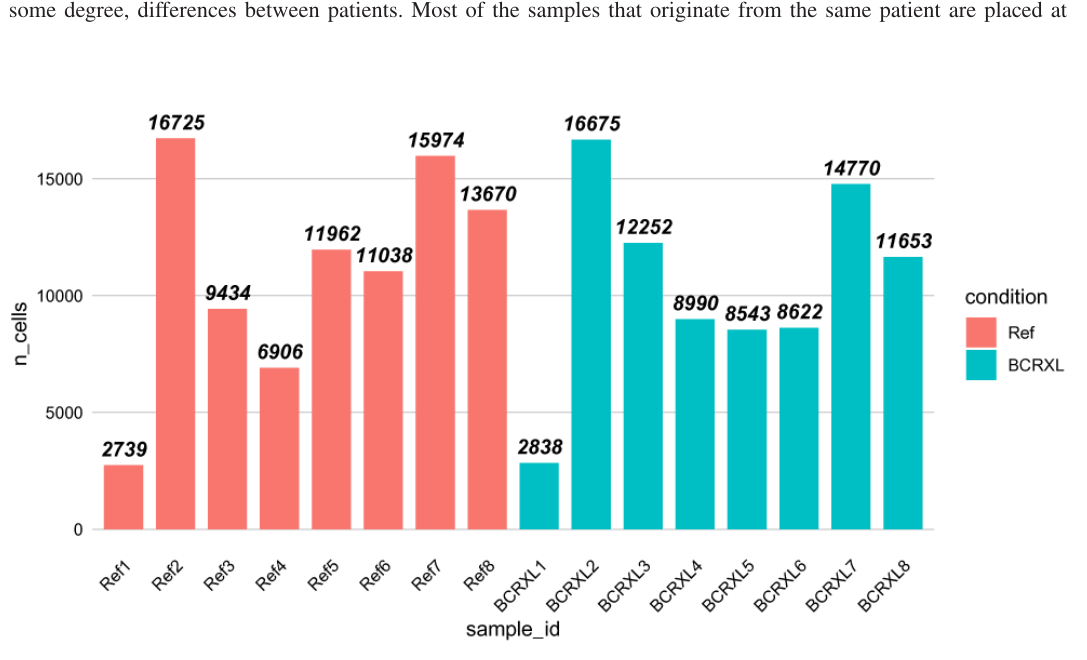
Figure 2. Barplot showing the number of cells measured for each sample in the PBMC dataset. Bars are colored by experimental condition: unstimulated (Ref) and stimulated with BCR/FcR-XL (BCRXL). Numbers in the names on the x-axis indicate patient IDs. Numbers on top of the bars indicate the cell